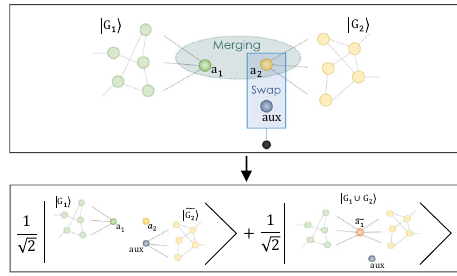
Fig. 4 Controlled merging. Schematic representation of controlled merging where the protocol is accomplished in the following way. If the control register is in the 0 j i state, the protocol preserves the two graph states unaltered, while the procedure merges the two graph states if the control register is in the 1 j i state.